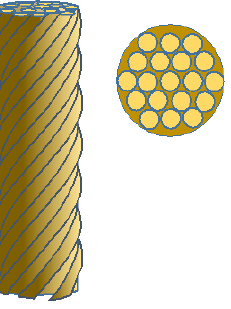
Figure 14. A sketch of a helical bundle of columns, which, it is proposed, slowly forms within columnar developable domain structures, giving rise to the straited appearance. Redrawn from Atkinson et al. [19].